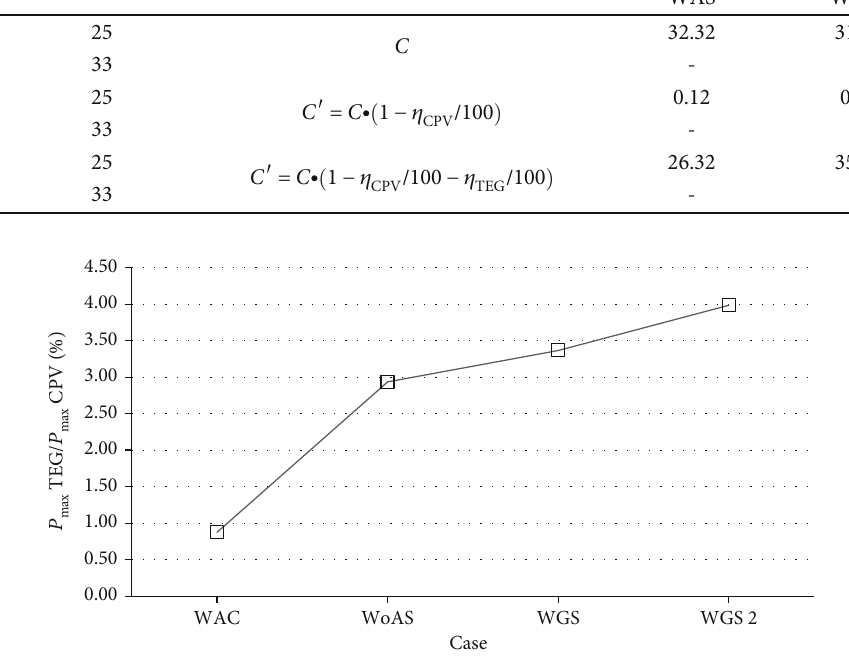
Figure 14: Ratio between the maximum power of the TEG and CPV versus considered